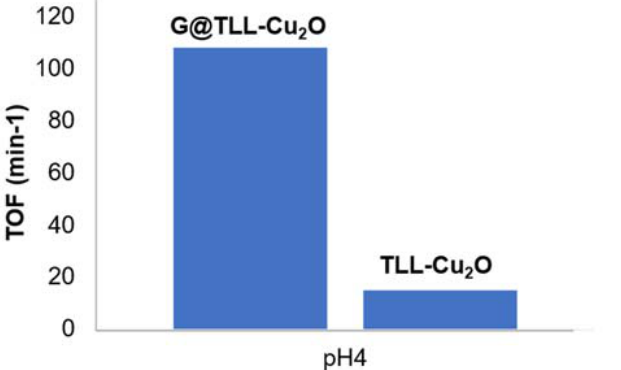
Figure 3. Comparative of TOF value (min − 1 ) between G@TLL-Cu 2 O hybrid and TLL-Cu 2 O (catalyst no supported) at 50:50 ACN:buffer acetate pH4. This experiment was calculated at 5 min with 20–30% of TCE elimination.